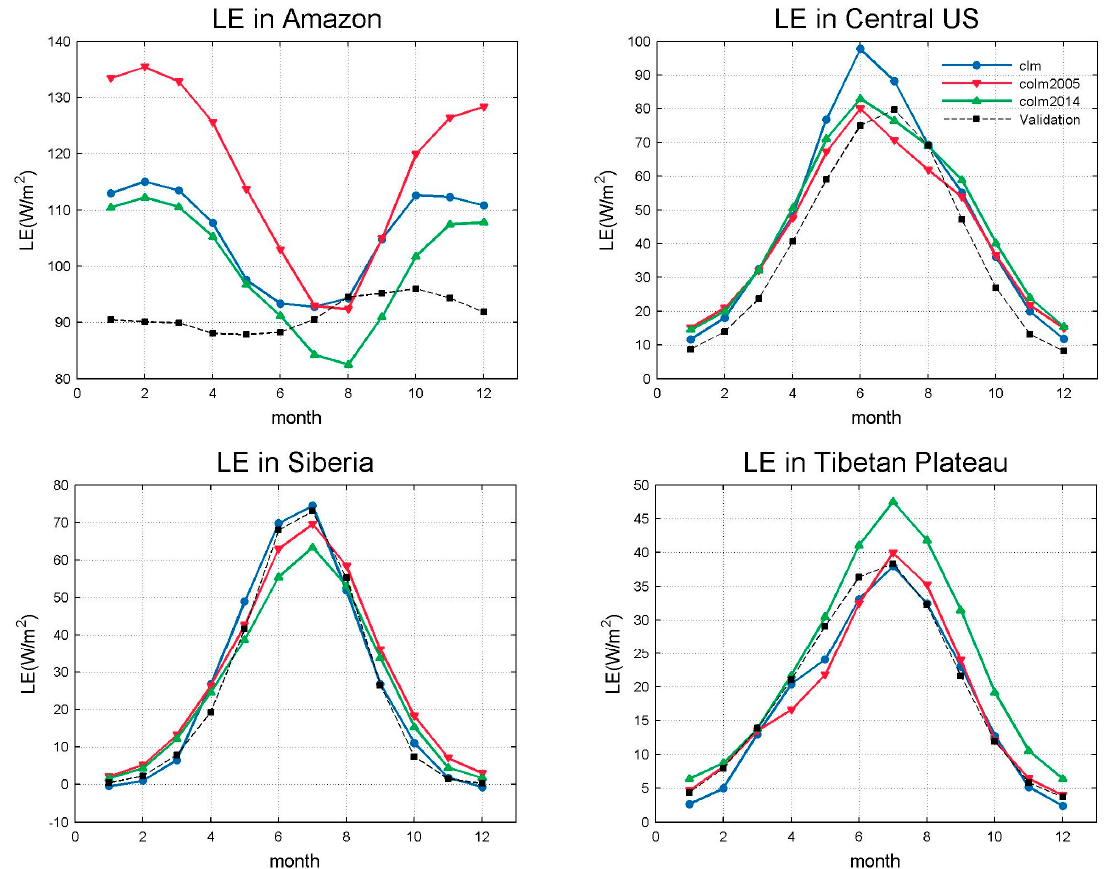
Figure 10. Same as Figure 3, but for latent heat flux (Units: W m − 2 ).